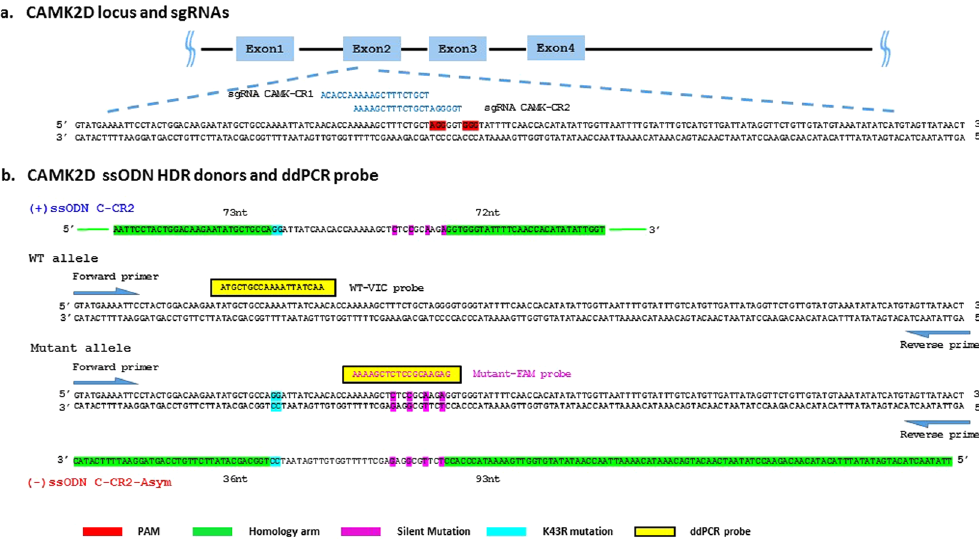
Figure 1. Single-stranded oligonucleotide (ssODN) donor design, droplet digital PCR probes and primer designs for gene editing and mutation detection at CAMK2D locus. ( a ) Two guide RNAs (CAMK-CR1 and CAMK-CR2) were designed to specifically target CAMK2D Exon2, CAMK-CR1 and CAMK-CR2 overlap by 14 nucleotides and were designed to cleave the DNA to introduce the same sequence alteration by HDR. ( b ) Two ssODN HDR donors (C-CR2 and C-CR2-Asym) were designed to introduce a kinase dead K43R mutation (AAA to AGG) and four silent mutations into Exon2 of the CAMK2D locus. The ssODN donor C-CR2 is a ( + ) strand HDR donor which is complementary to the guide RNA targeted cleavage strand with balanced homology arms around each side of the intended mutations (5 ′ -73nt and 3 ′ -72nt, respectively). C-CR2-Asym is a ( − ) strand HDR donor which is complementary to the guide RNA non-targeted strand with homology arms that differ in length (5 ′ -93nt and 3 ′ -36nt, respectively). To prevent subsequent re-cleavage, both donor oligo C-CR2 and C-CR2-Asym introduces three silent mutations within the guide CAMK-CR1 recognition site and one silent mutation within the PAM site. C-CR2 and C-CR2-Asym introduces four silent mutations